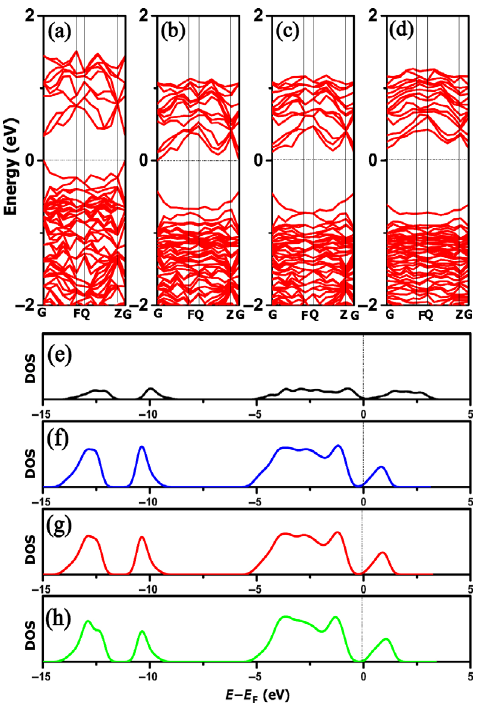
Figure 4 The band structures of (a) Bi 2 Se 3 , (b) Ce 0.15 Bi 1.85 Se 3 , (c) Ce 0.3 Bi 1.7 Se 3 (d) Ce 0.4 Bi 1.6 Se 3 elucidating a downward shift of the valence band and the calculated total density of state (TDOS ) of (e) Bi 2 Se 3 , (f) Ce 0.15 Bi 1.85 Se 3 , (g) Ce 0.3 Bi 1.7 Se 3 , (h) Ce 0.4 Bi 1.6 Se 3 . Adapted with permission from Ref. [100], © American Chemical Society 2019.